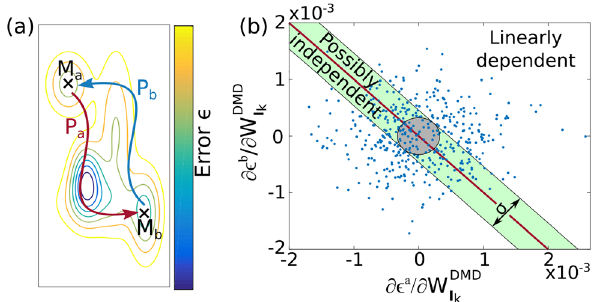
Figure 5: (a) Two inverted paths are probed between two local minima.(b)Errorgradientforallreadoutweightsencounteredalong path one and two as x and y axis, respectively. The red diagonal corresponds to linear independent weights, and the uncertainty induced by noise is indicated by the green area. Within, weights are potentially linear independent. Outside the green area weights are linearly dependent, and for data inside the grey circle of diameter σ no classi fi cation is